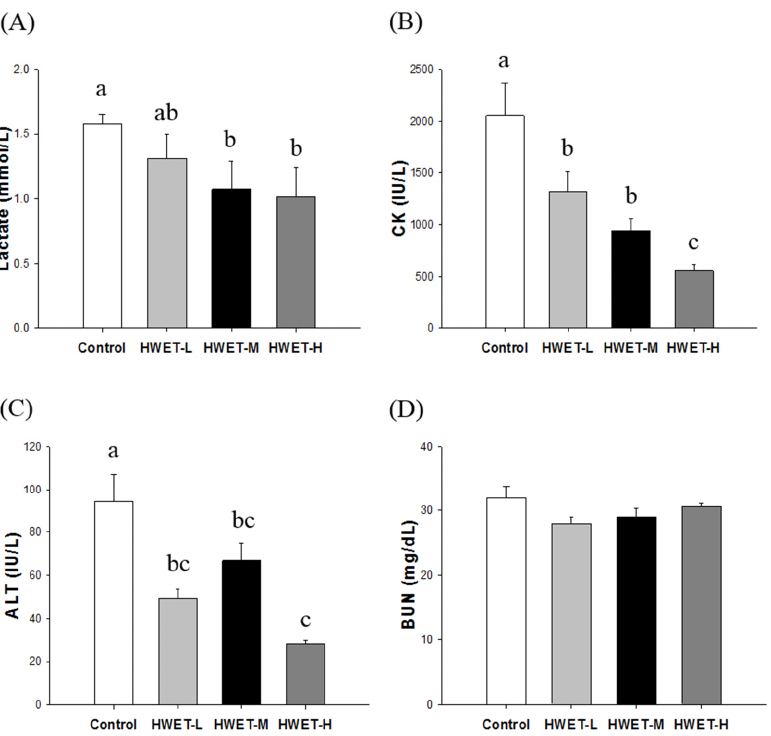
Figure 2. Effects of HWET treatment on serum levels of ( A ) lactate, ( B ) creatine kinase (CK), ( C ) alanine aminotransferase (ALT), and ( D ) blood urea nitrogen (BUN) in mice after a swimming endurance test. Values are expressed as the mean ± SEM. Different letters indicate statistical difference, p < 0.05.